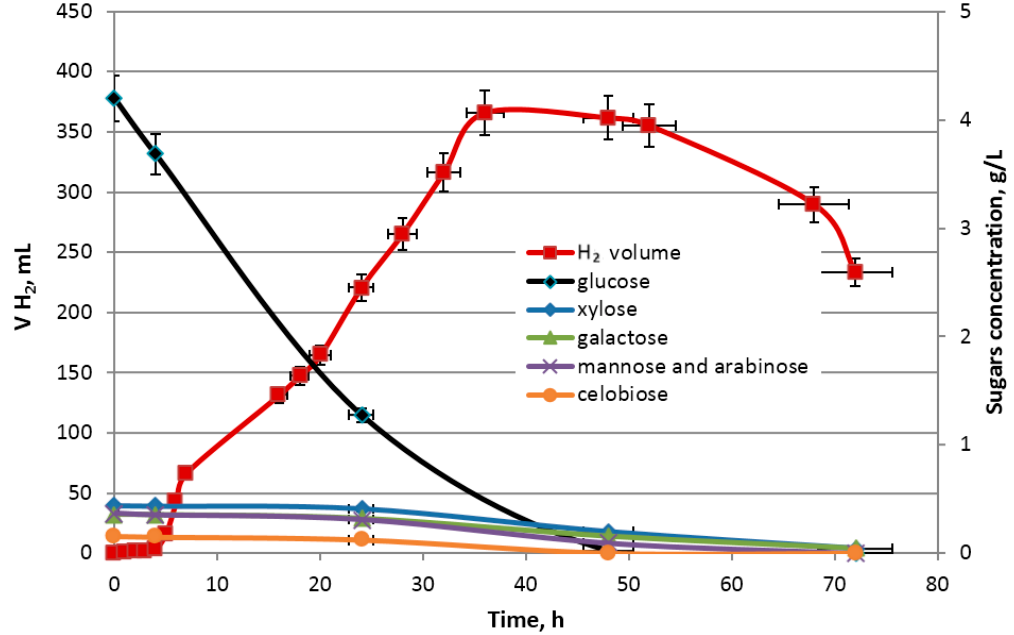
Figure 7. Changes in the volume of obtained hydrogen corresponding to changes of sugars concentrations during dark fermentation. Molecules 2018 , 23 , x FOR PEER REVIEW 15 of 22